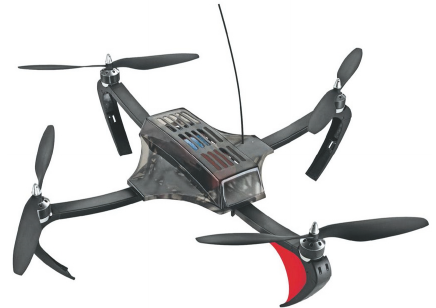
Figure 1: The adopted small quadrotor (Conrad 450 ARF 35